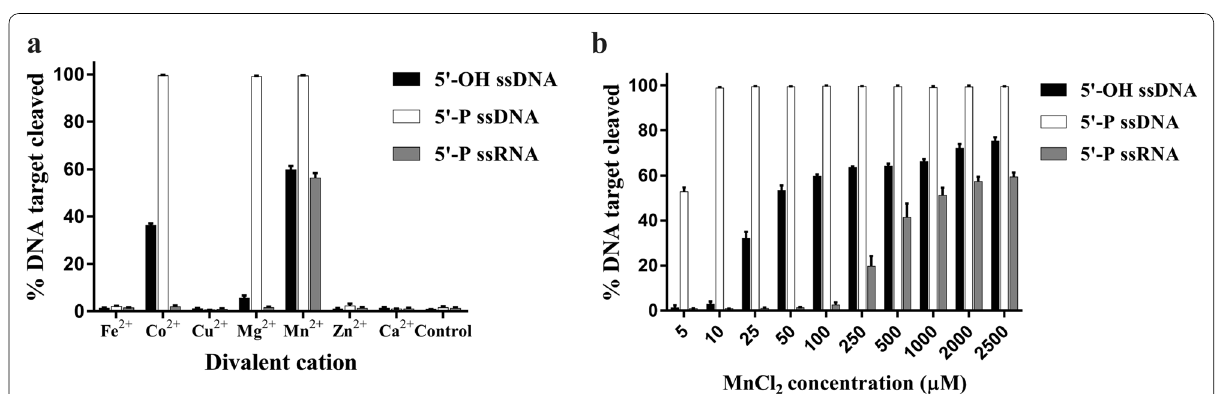
Fig. 5 Effects of different divalent cations and Mn 2 + concentrations on Mf Ago activity. a Effect of different divalent cations on enzyme activity. b Effect of Mn 2 + concentration on enzyme activity. Error bars represent the SDs of three independent experiments